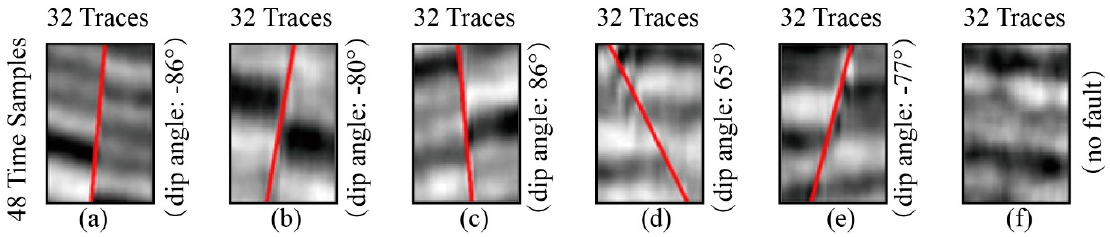
Figure 2. Some synthetic training samples, red solid lines indicate their corresponding labels.